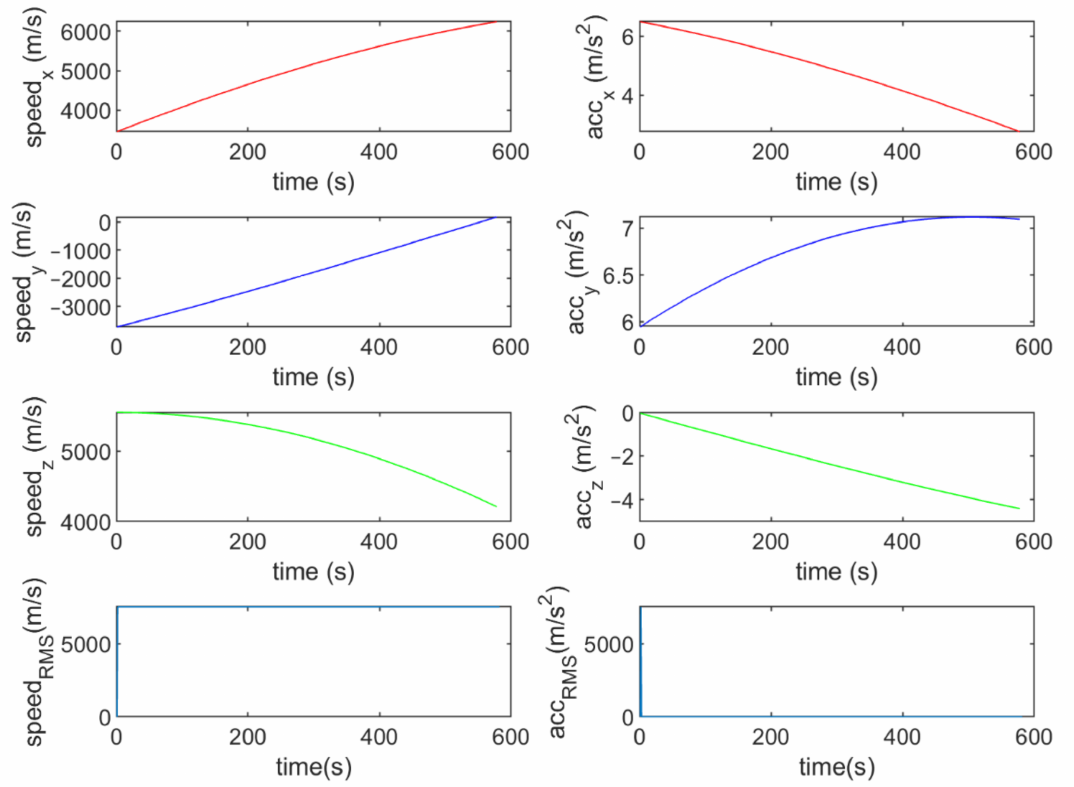
Figure 15. The speed and acceleration components in the sixth